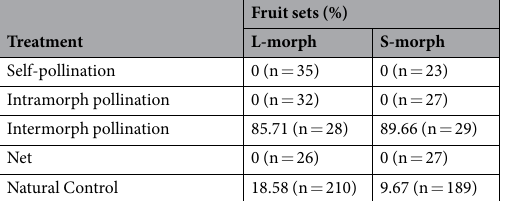
Table 2. Fruit sets of Guettarda speciosa with different pollination